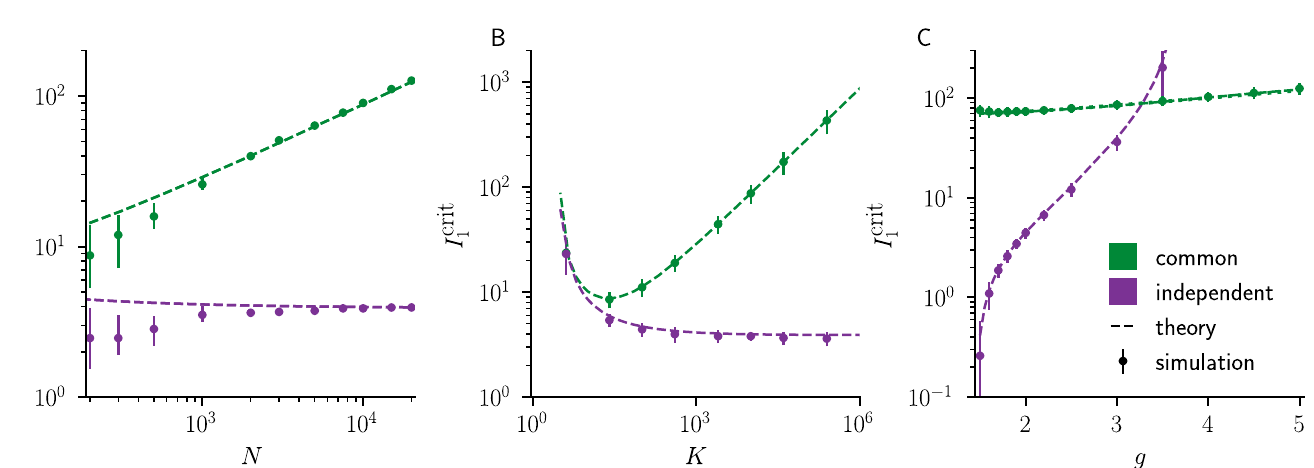
Fig 3. Difference in chaos suppression increases with network size, tightness of balance, and near the transition to chaos. A) Dependence of I crit ffiffiffiffi p With common input, I crit / for large N , but is constant for independent input. Error bars indicate interquartile range around the median. B) Dependence of I crit N 1 ‘tightness of balance’ parameter K , which scales both I 0 and J 0 . Results for large K are the same as in A but for small K , the network is no longer in the balanced regime, and results for common and independent input become similar. Error bars indicate ± 2 std. C) Dependence of I crit , an arbitrarily small independent input can suppress chaos; this is not the case with common input. The quasi-static approximation (dotted) and DMFT (dashed) g crit results coincide. Error bars indicate ± 2 std. Model parameters: I 0 = J 0 = 1 in A and C ; g = 2, f = 0.2/ τ in A and B ; I and C .